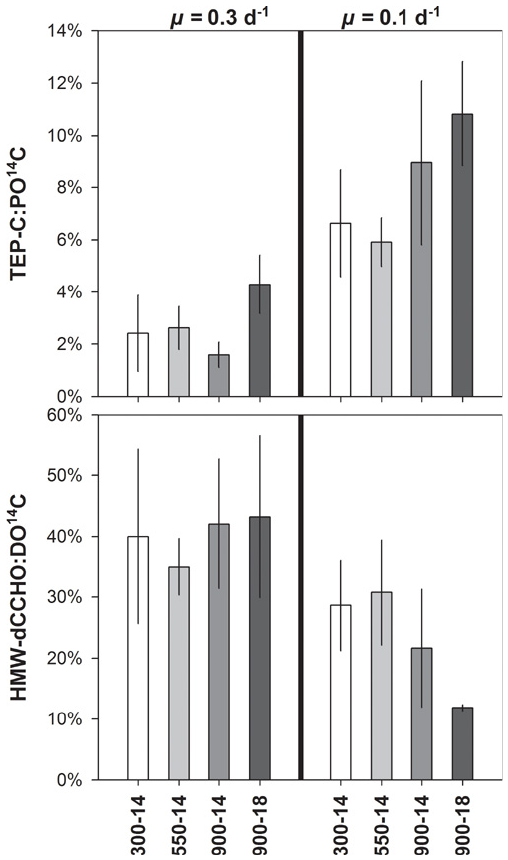
Fig. 7. Carbon partitioning. Contribution (mol% C) of the carbon content of transparent exopolymer particles (TEP-C) to particu- late organic carbon (PO 14 C), (upper panel) and of high molecular weight ( > 1kDa) dissolved CCHO (HMW-dCCHO) to dissolved or- ganic carbon (DO 14 C, µmol C l − 1 ) various growth-, CO 2 and tem- perature conditions. Mean values and standard deviations were de- rived from sampling 1, 2 and 3 ( µ = 0 . 3d − 1 ) and sampling 4, 5 and 6 ( µ = 0 . 1d − 1 ) , respectively. Concentrations (µmoll − 1 ) of PO 14 C and DO 14 C were calculated from production rates (µmoll − 1 d − 1 ) by applying Eq.